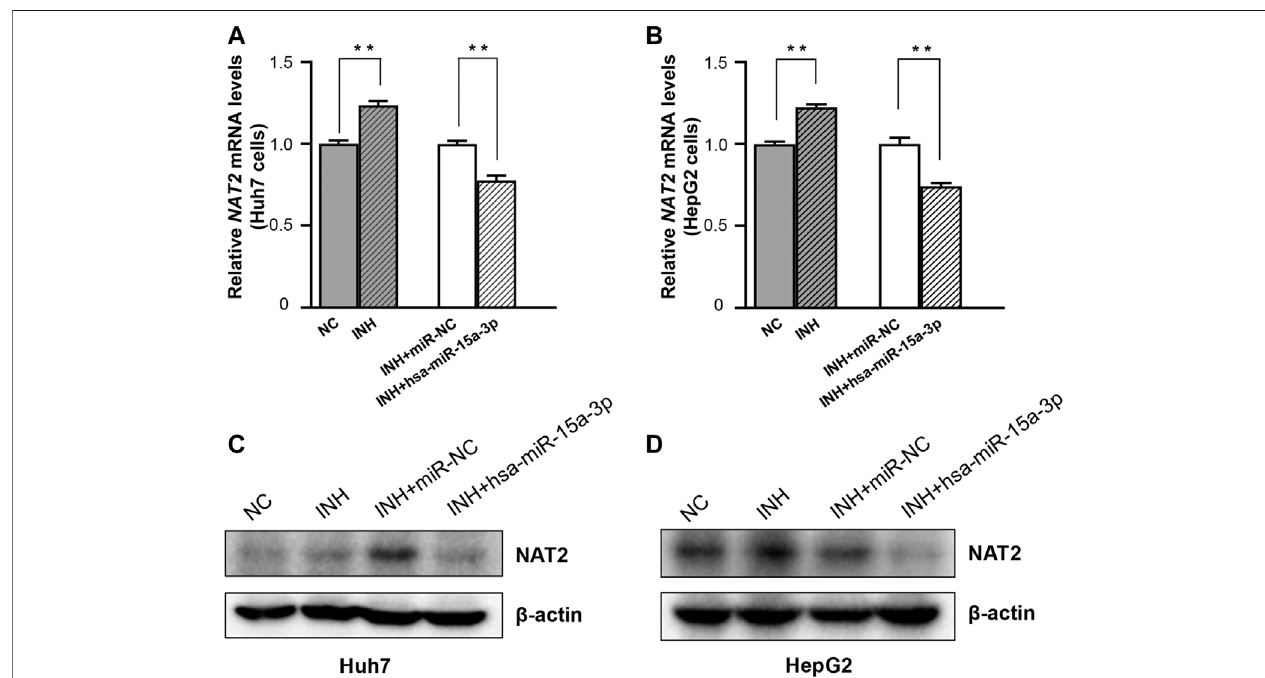
FIGURE 4 | The hsa-miR-15a-3p suppressed INH-induced NAT2 expression in Huh7 and HepG2 cells. (A,B) Effect of exogenous hsa-miR-15a-3p on NAT2 mRNA levels in Huh7 and HepG2 cells exposed to INH ( fi nal concentration: 40 mM). (C,D) Effect of exogenous hsa-miR-15a-3p on NAT2 protein levels in Huh7 and HepG2 cells exposed to INH ( fi nal concentration: 40 mM). Data represented three independent experiments and were shown as mean ± SD. The fold changes of mRNAs, and proteins in INH treatment group (INH) were calculated by de fi ning their levels in the untreated group (NC) as 1. Similarly, the fold changes of mRNAs, and proteins in the group of INH treatment together with miR-15a-3p transfection (INH + hsa-miR-15a-3p) were calculated by de fi ning their levels in the group of INH treatment together with miRNA negative control transfection (INH + miR-NC) as 1. ** p <